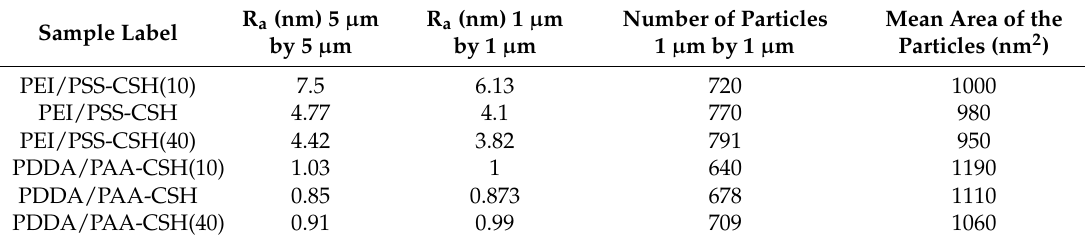
Figure 7. Segmentation of the AFM scan of PEI/PSS-CSH(10) using the watershed algorithm. Table 3. Roughness value, number of particles, and mean area of the nanocomposites fabricated with different dipping